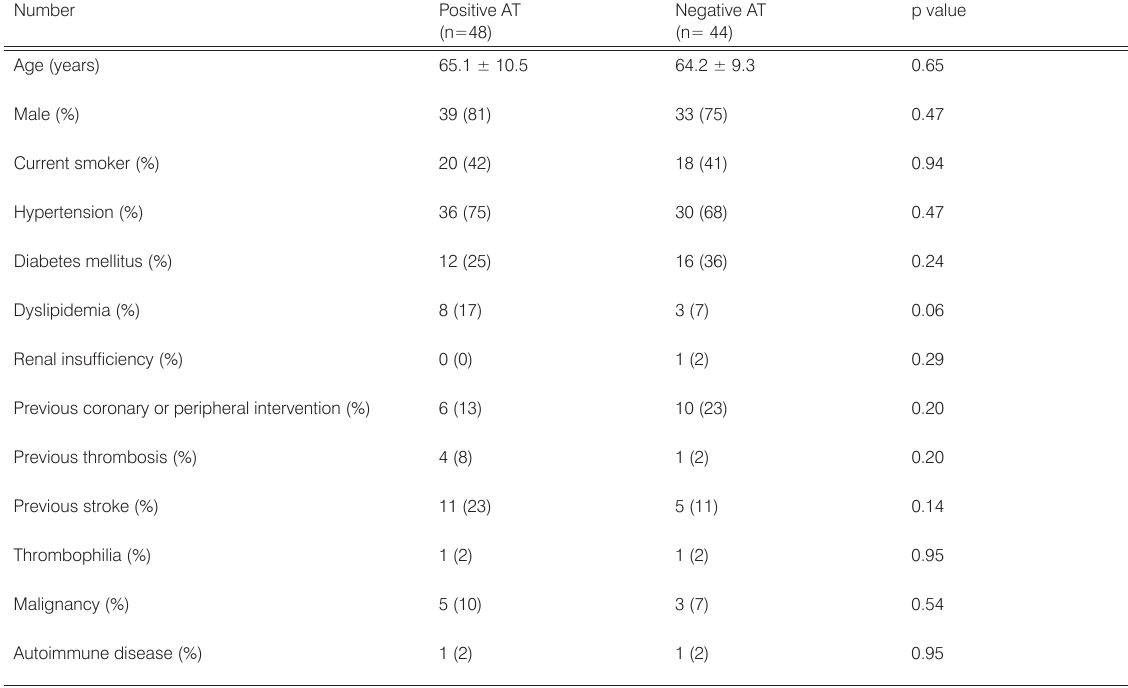
Table 1. Demographic and clinical charecteristics of patient with positive and negative Allen’s